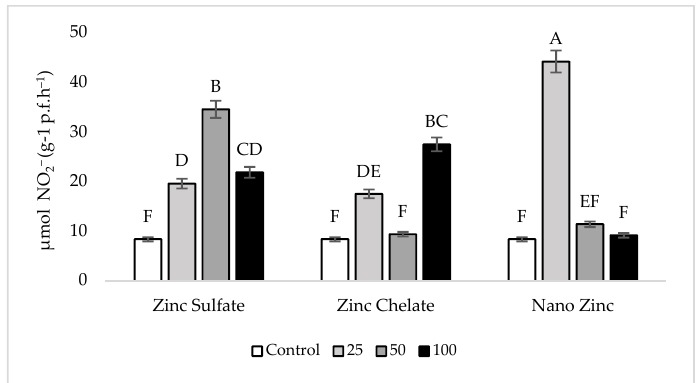
Figure 5. Endogenous nitrate reductase activity induced by nitrates due to the effect of applying nanofertilizers, chelates, and zinc sulfates in green beans cv. Strike. Letters show significant differences.